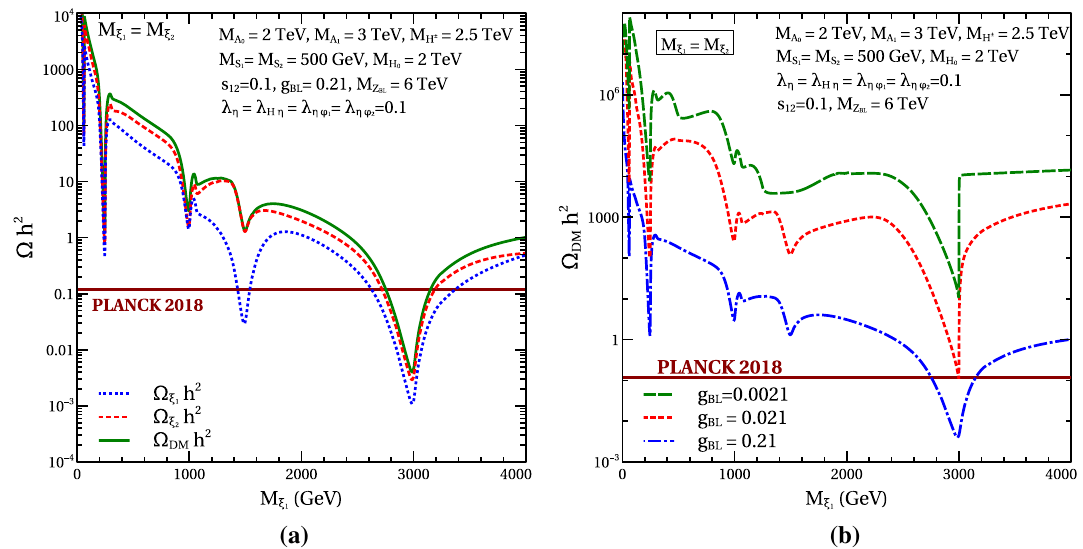
(cid:8) (cid:9) (cid:5) 2 = (cid:5) ξ h 2 + (cid:5) ξ h 2 with degenerate masses M ξ DM h 1 2